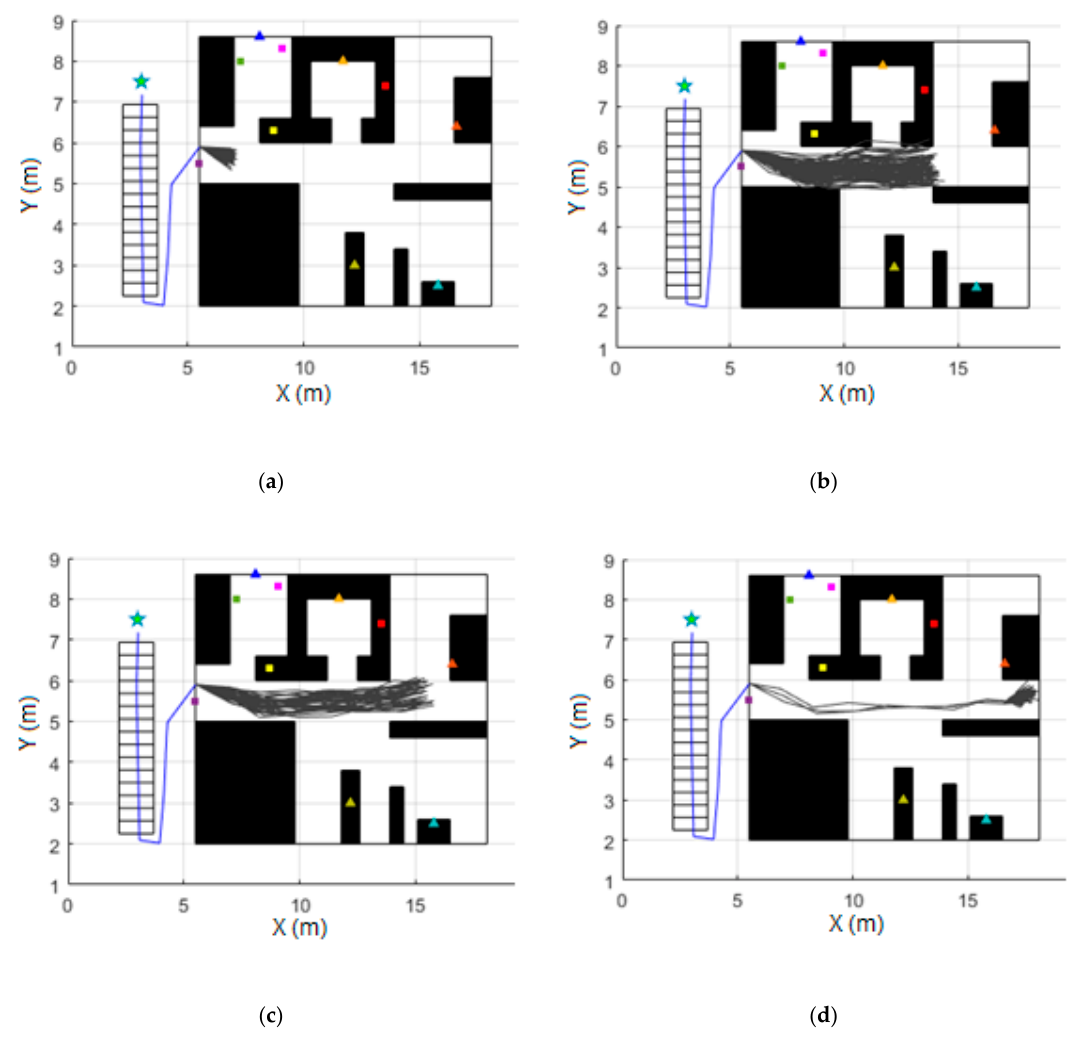
Figure 5. Example of prediction, update, and resampling phases: ( a ) the particle filter is initialized once the movement of the door is detected. 600 new different trajectories (gray lines) are created, and the prediction phase is executed when one stride is detected; ( b ) Possible trajectories just before receiving the first RSSI measurement from the beacon in the room; ( c ) Update and resampling phases are run for the first time when the RSSI measurement is processed; ( d ) Update and resampling phases are run when with the second RSSI measurement received.